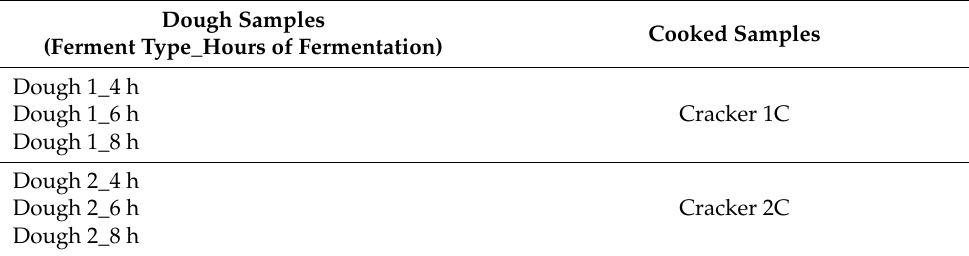
Table 1. List of samples submitted for